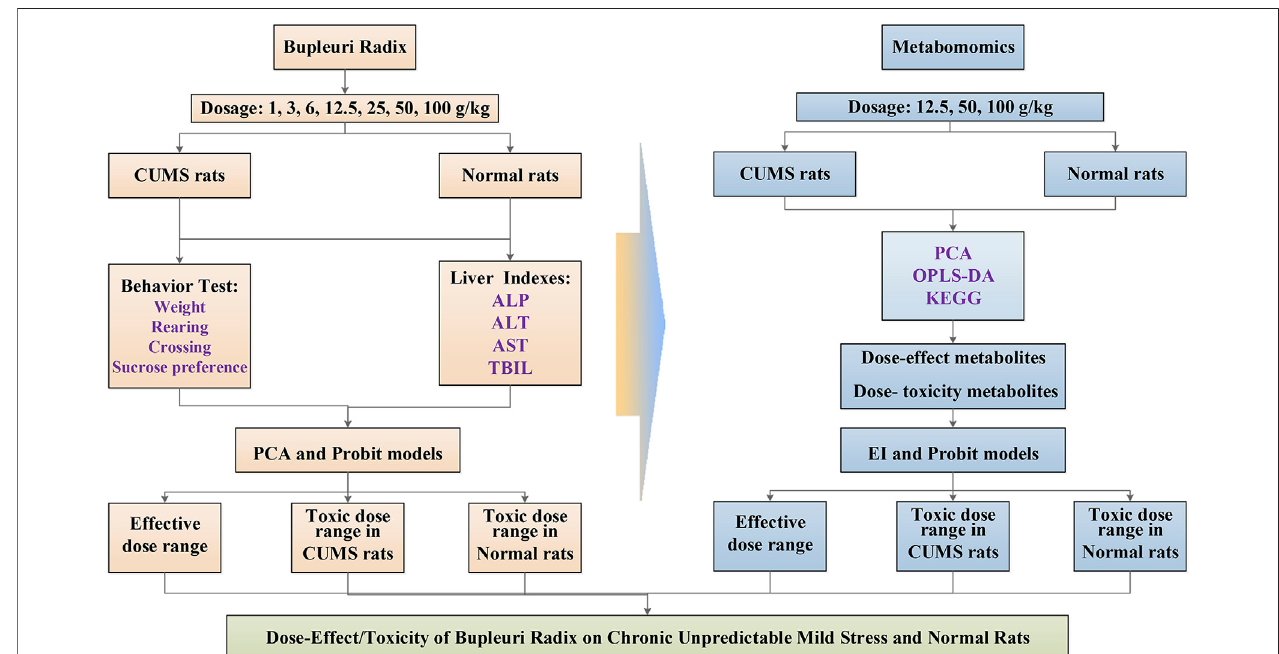
FIGURE 1 | Schematic diagram of dose-effect/toxicity of bupleuri radix on CUMS and normal rats.